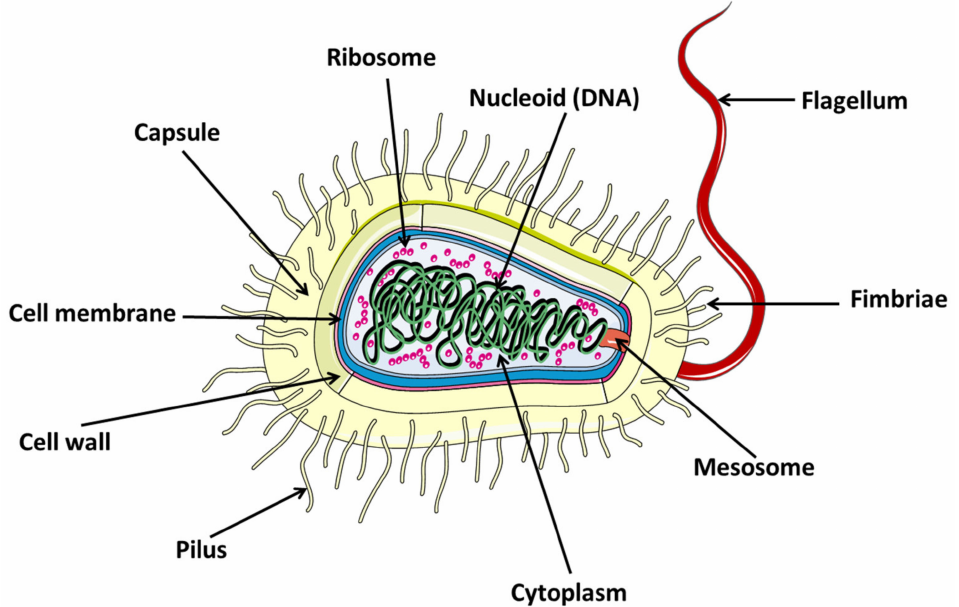
Figure 1. Structure of bacterial